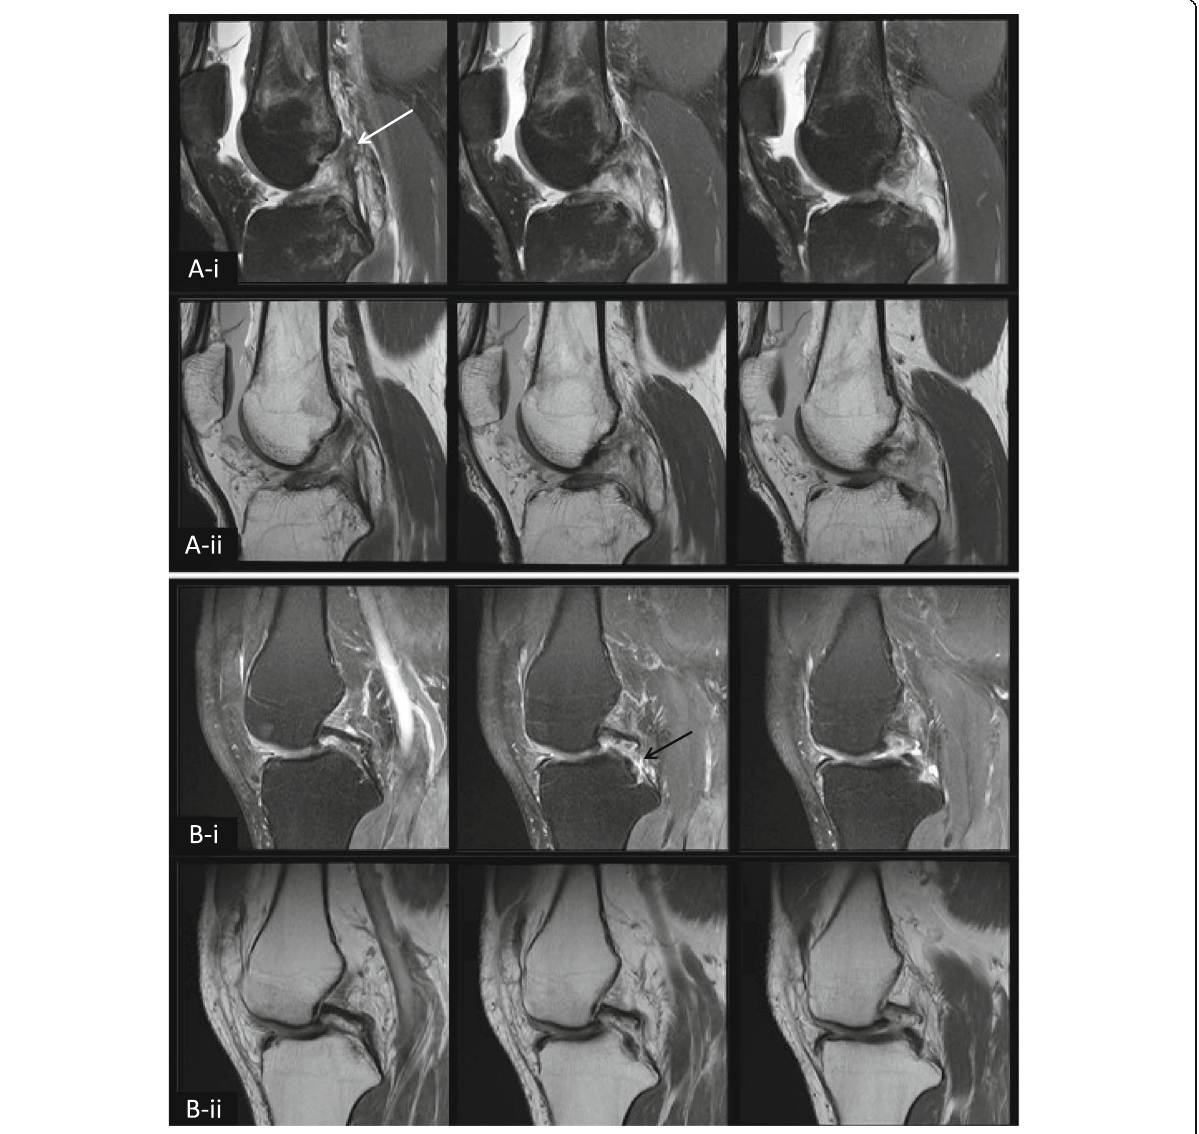
Fig. 1 Example images from two subjects with complete PCL tears. Subject A had a chronic injury in which the PCL was detached from the femoral attachment (white arrow). Subject B had a chronic injury in which the PCL was partially torn at its tibial attachment (black arrow). Images shown are from three consecutive slices of i) a PD FS TSE sequence (sagittal plane; TR/TE: 5300/40 ms; interpolated resolution: 0.19 × 0.19 mm; slice thickness: 3.0 mm; FOV: 120 mm; TA: 2 min 50 s) and ii) a PD TSE sequence (sagittal plane; TR/TE: 2500/32ms; interpolated resolution: 0.16 × 0.16 mm; slice thickness: 3.0 mm; FOV: 125 mm; TA: 3 min 19